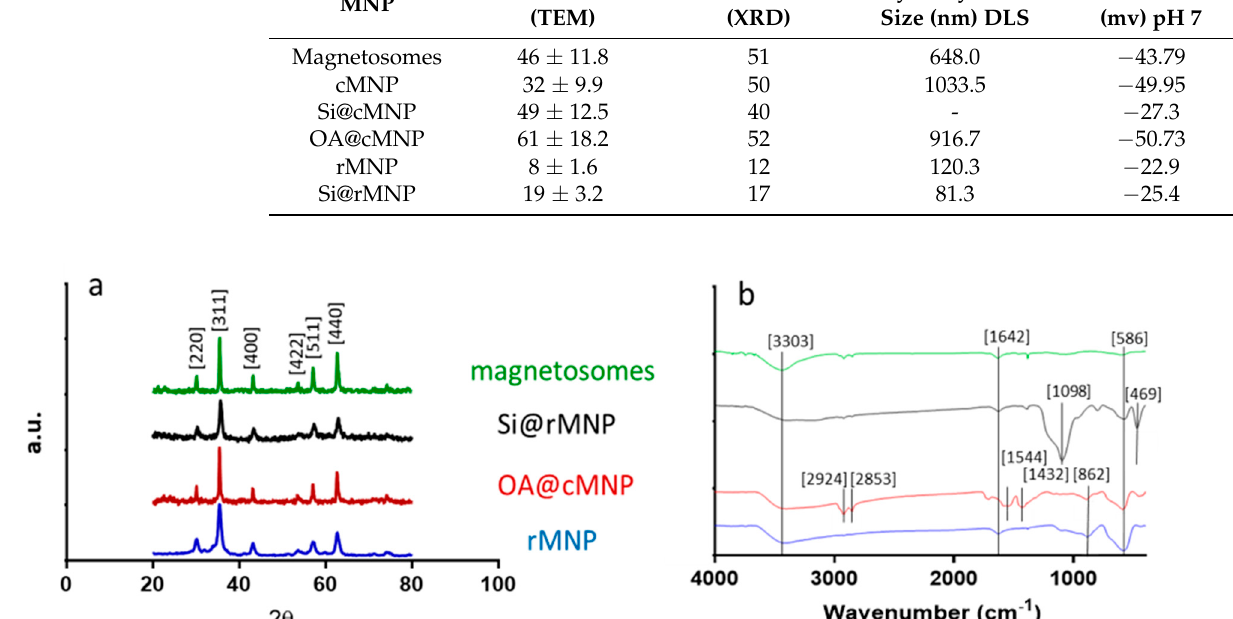
Figure 3. Structural and chemical analysis of the magnetosomes and synthesized MNP. ( a ) XRD spectra showing the diffraction peaks with 2 θ angle measurements from 20 to 80. ( b ) FTIR spectra with wavenumber from 400–4000 (cm − 1 ).